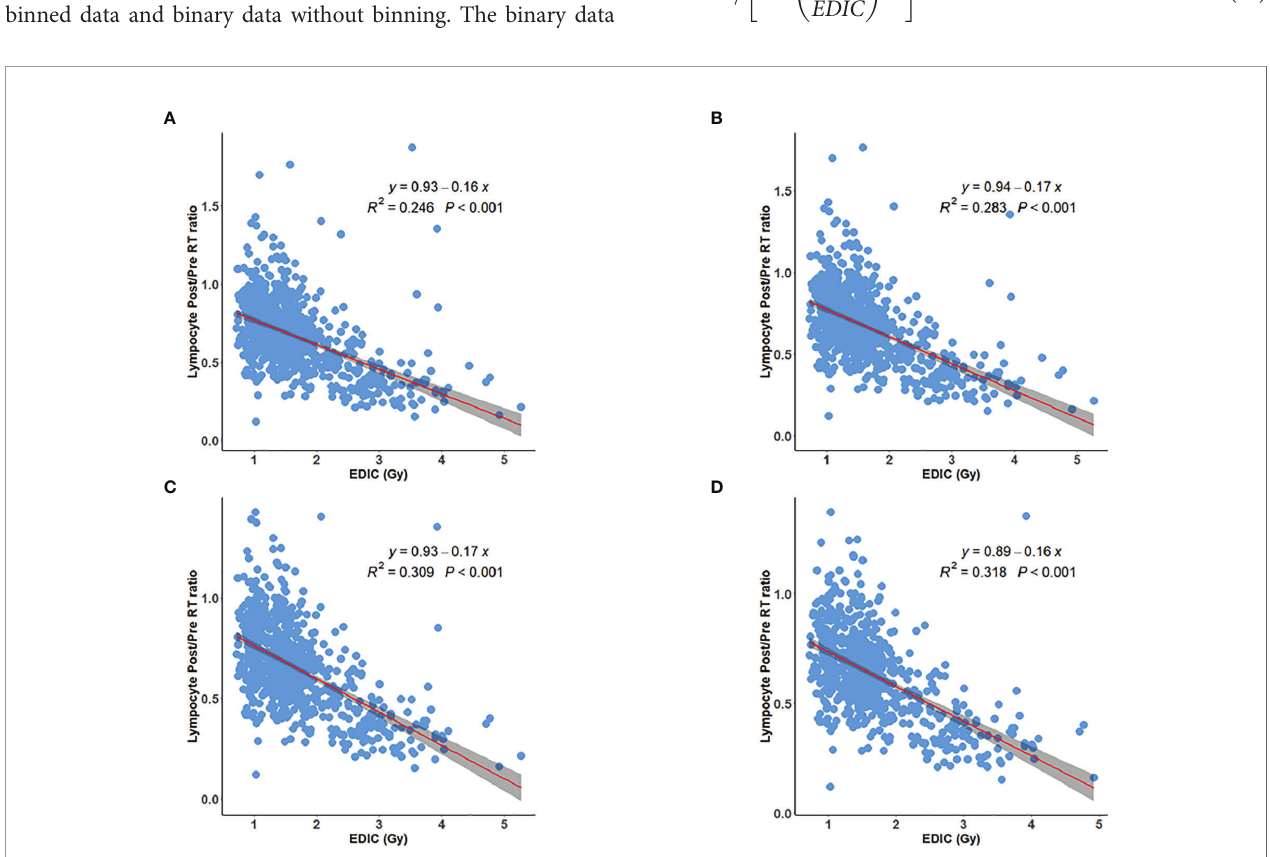
FIGURE 1 | Inverse linear relation between post/preRT PLC Ratio and EDIC for (A) all 735 patients; (B) 732 patients excluding 3 patients with grade 3 preRT lymphopenia; (C) 714 patients excluding additional 18 patients with grade 2 preRT lymphopenia; (D) 630 patients excluding additional 84 patients with grade 1 preRT